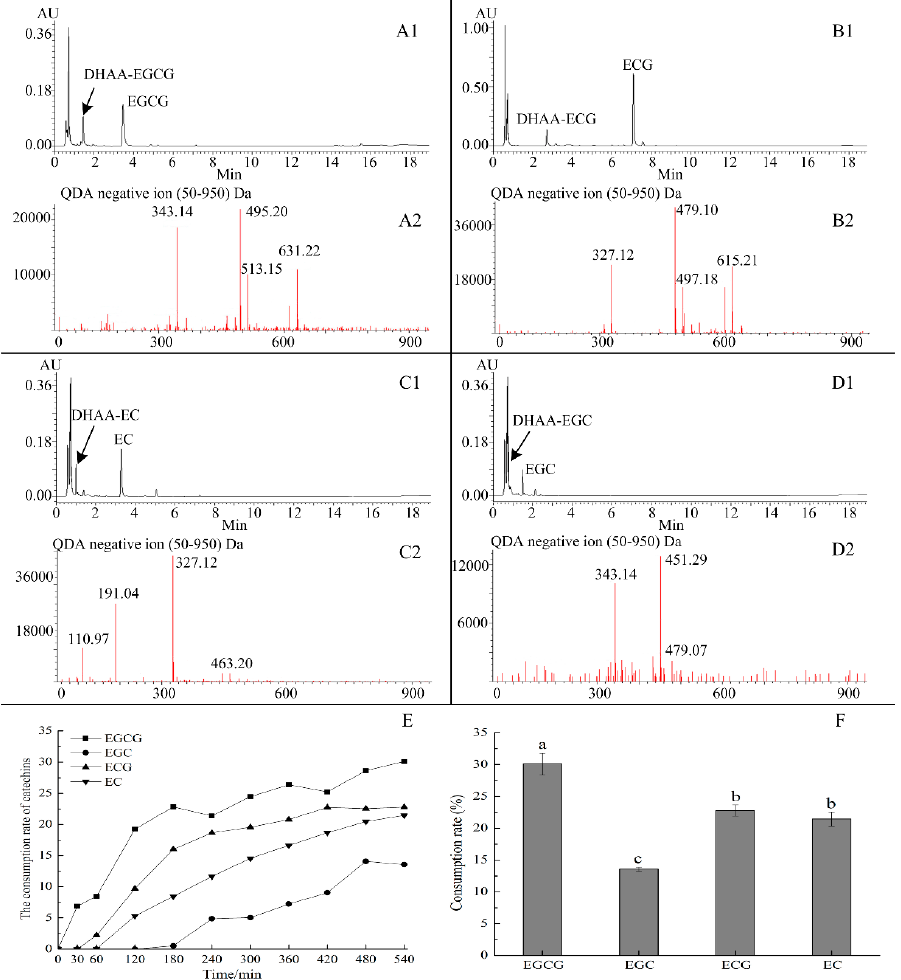
Figure 5. Chromatograph profile and mass spectrum of ascrbyl adducts of catechins. ( A1 , B1 , C1 , D1 ) represent the liquid chromatogram of ascorbyl conjunctions of ( − )-epigallocatechin gallate (EGCG), ( − )-epicatechin (EC), ( − )-epicatechin gallate (ECG), and ( − )-epigallocatechin (EGC). ( A2 , B2 , C2 , D2 ) represent the negative mass spectrum of ascorbyl conjunctions of EGCG, ECG, EC, and EGC, respectively. ( E ) represents the changes of consumption rate of four catechins during storage. ( F ) represents the consumption rate of four catechins at 540 min. Date represent means ± SD of three replicate samples. Different letters indicate significant differences according to Duncan’s multiple range test ( p < 0.05). Table 1. Precursor ion and characteristic fragment ion of substrates and new products.